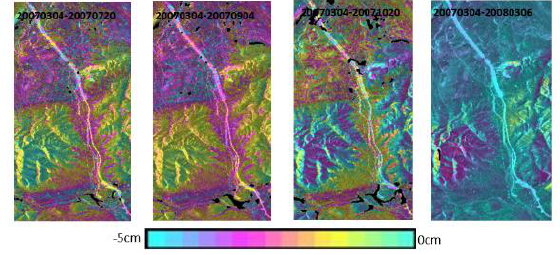
Figure 4. Deformation map of the study area